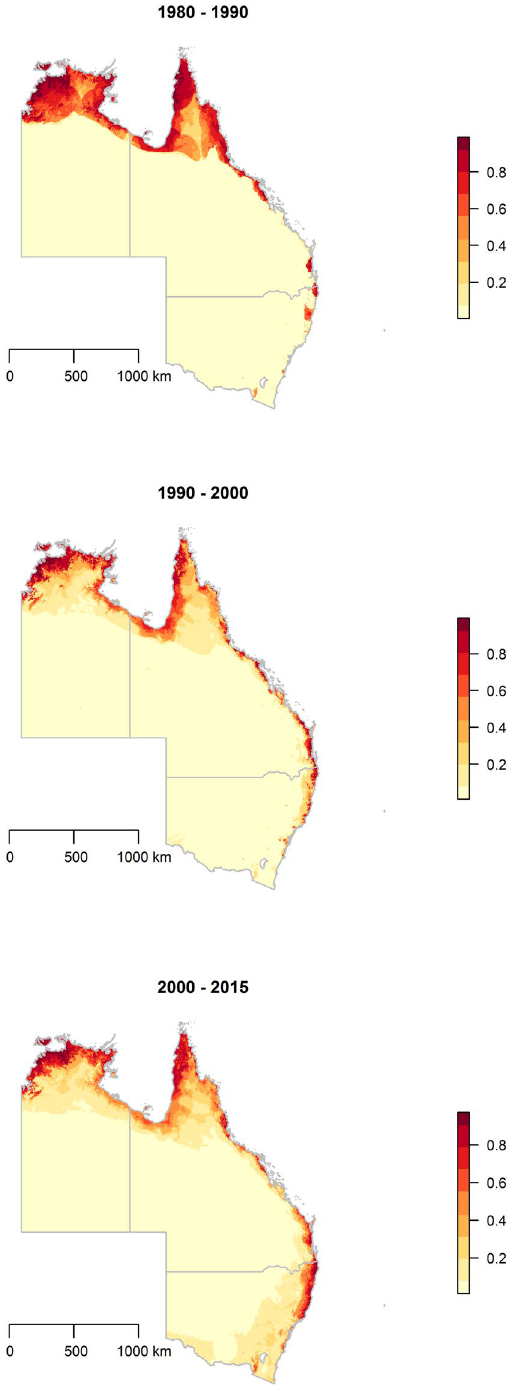
Figure 4. Changing ecological niche of Hendra virus reservoirs. These maps show the probability of landscape suitable to natural reservoirs of Hendra virus for each of three periods based on observations of Pteropus alecto and P. conspicillatus during 1980–1989, 1990–1999, and 2000–2015, respectively. The ecological niches were modeled using boosted regression trees. All maps created in R (v. 3.3.1) 42